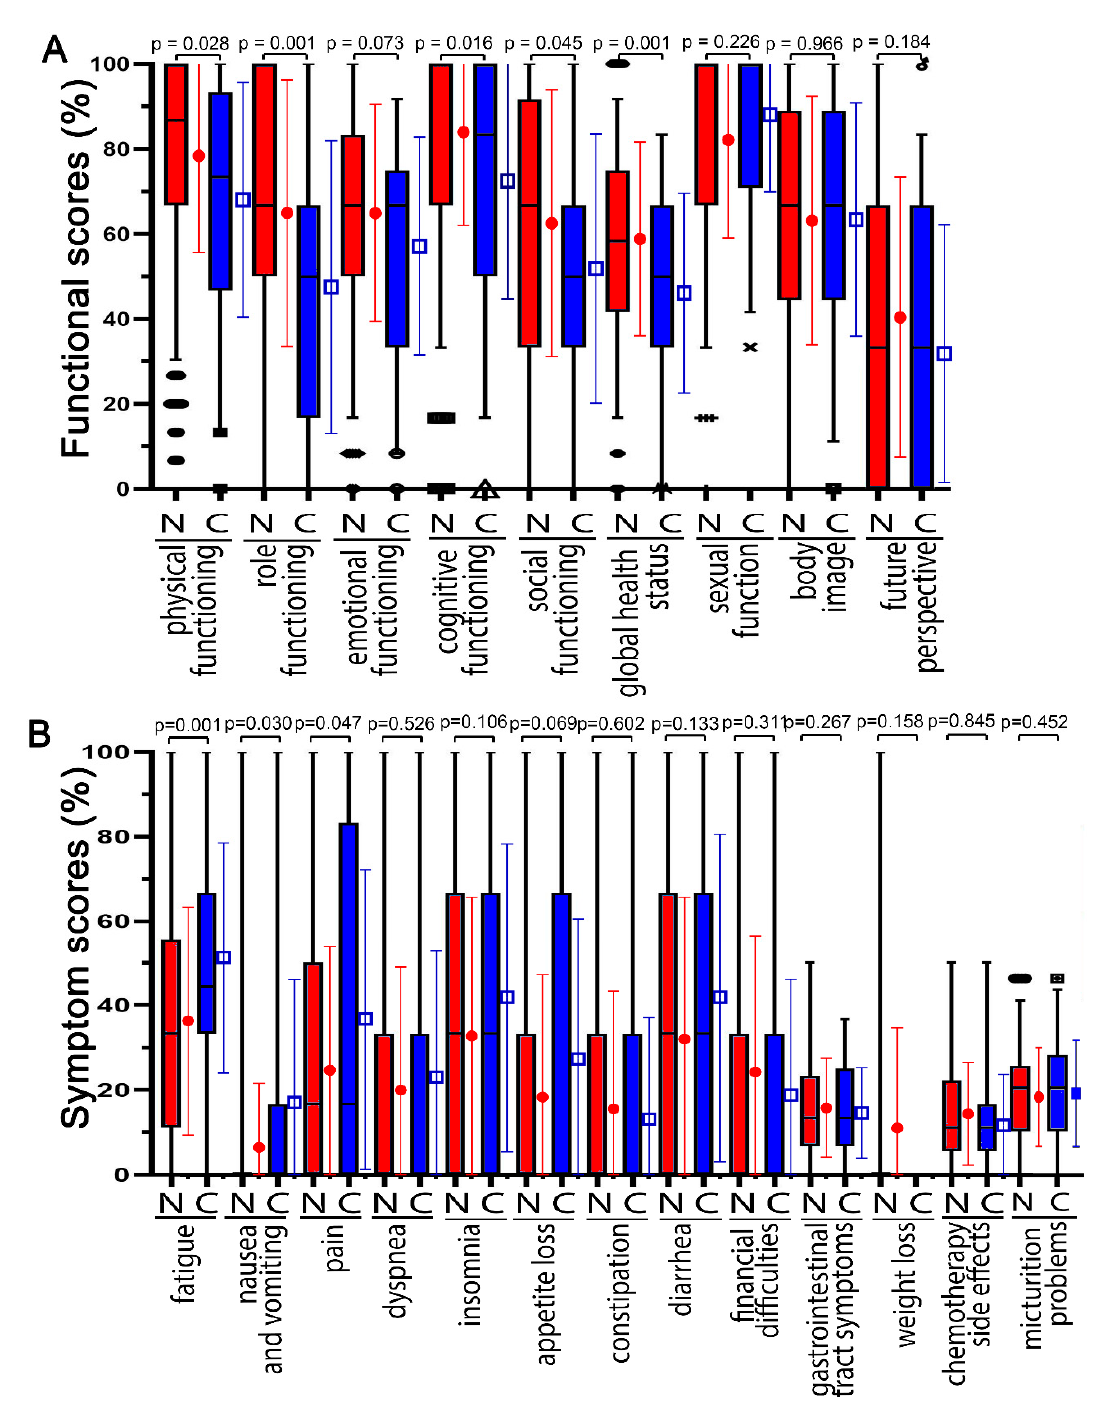
Figure 2. The functional and symptom score distribution of prior to the COVID-19 pandemic (N = non COVID) compared with during the COVID-19 pandemic (C = during COVID pandemic). Baseline values were surveyed on day 1 before radiochemotherapy. ( A ) Functional scores are: physical functioning, role functioning, emotional functioning, cognitive functioning, social functioning, global health status, sexual function, body image, and future perspective. ( B ) Symptom scores are: fatigue, nausea and vomiting, pain, dyspnea, insomnia, appetite loss, constipation, diarrhea, financial difficulties, gastrointestinal tract symptoms, weight loss (WL), chemotherapy side effects, and micturition problems. The different symbols signify the outliers and extreme values. □ and ● indicate the mean and error bars the standard deviation.